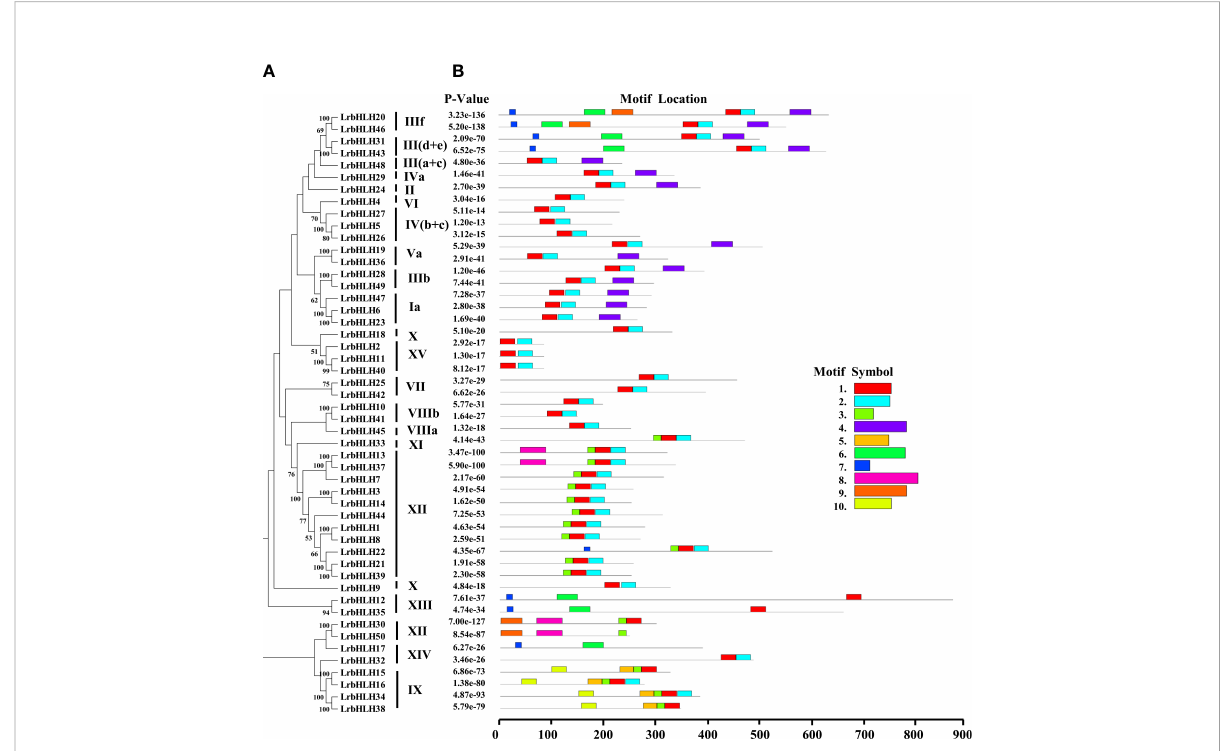
FIGURE 2 The phylogenetic relationships and conserved motifs analysis of LrbHLH proteins. (A) Neighbor-joining LrbHLHs phylogenetic tree (bootstrap values for 1000 replicates); (B) Conserved motifs distribution in LrbHLH proteins. Different motifs are represented with different colored boxes. The motif length is represented by the box